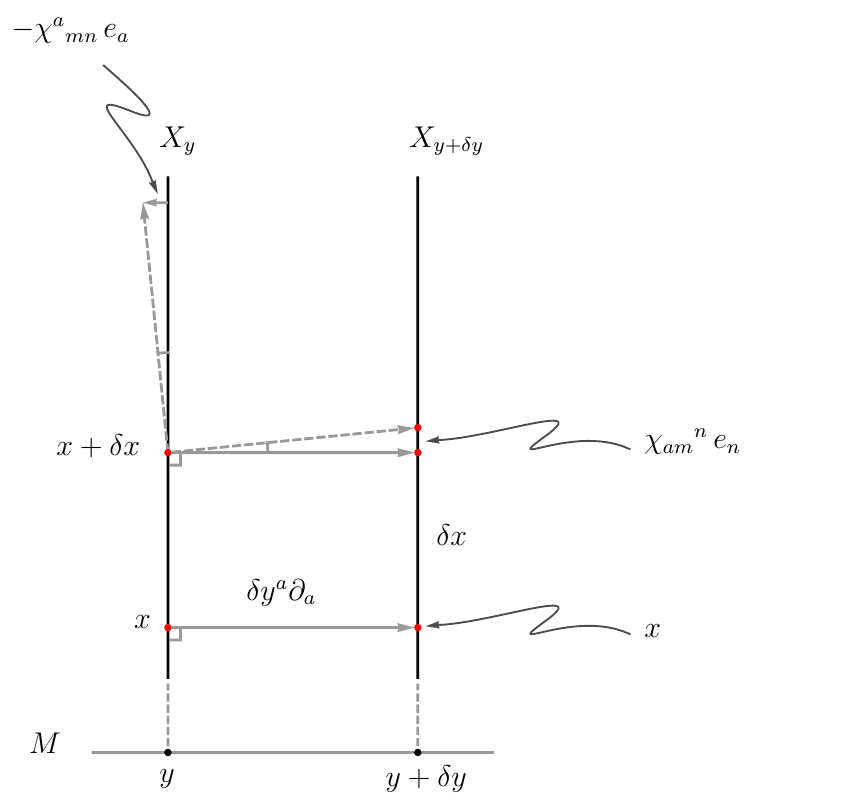
Figure 2 . The calculation of the extrinsic curvature for the fibres X y for the case that c am = 0